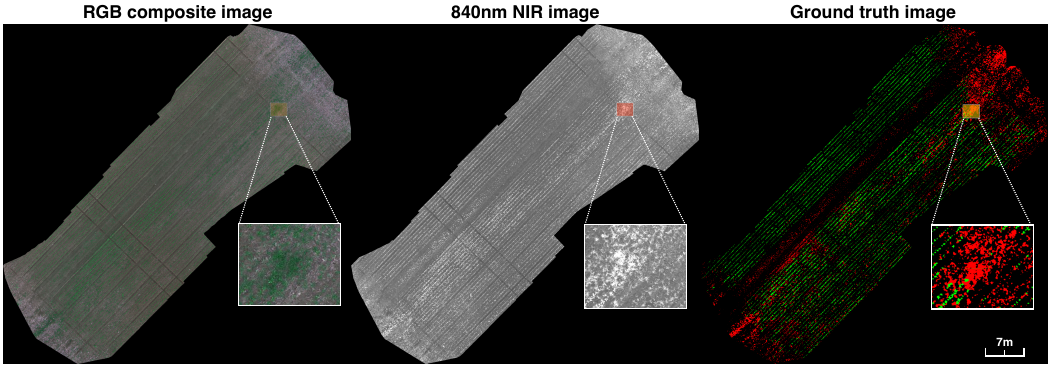
Figure 1. An example of the orthomosaic maps used in this paper. Left, middle and right are RGB (red, green, and blue). composite, near-infrared (NIR) and manually labeled ground truth (crop = green, weed = red) images with their zoomed-in views. We present these images in order to provide an intuition of the scale of the sugar beet field and quality of data used in this